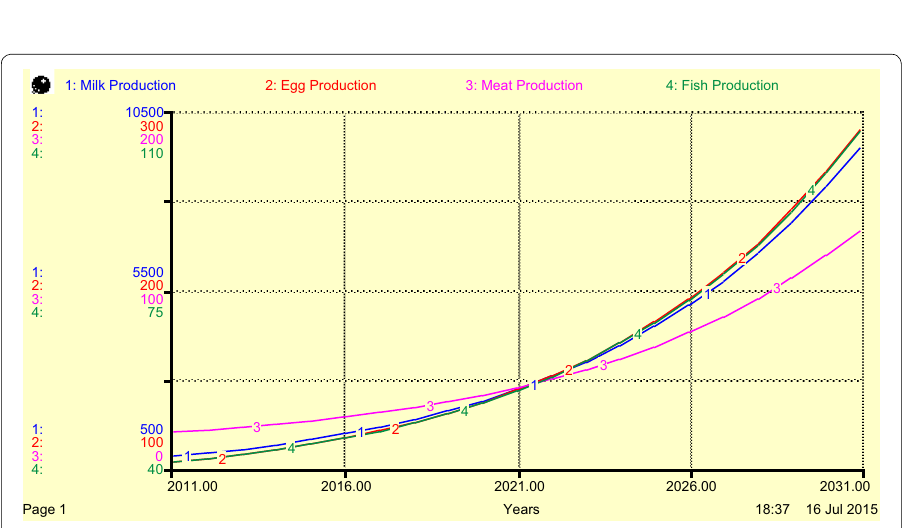
Fig. 14 Projected production of milk, egg, fish, and meat up to